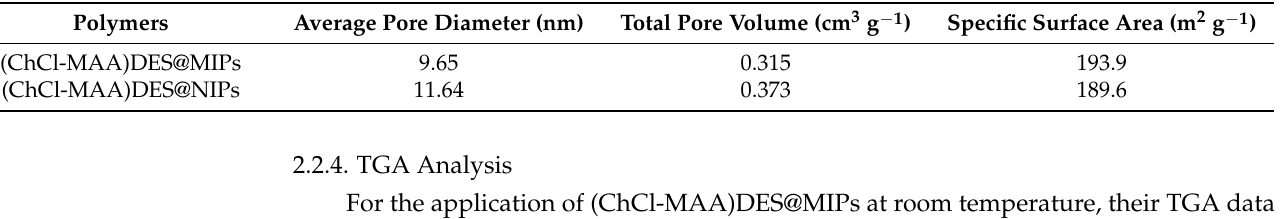
Table 1. Data of pore size and specific surface area.